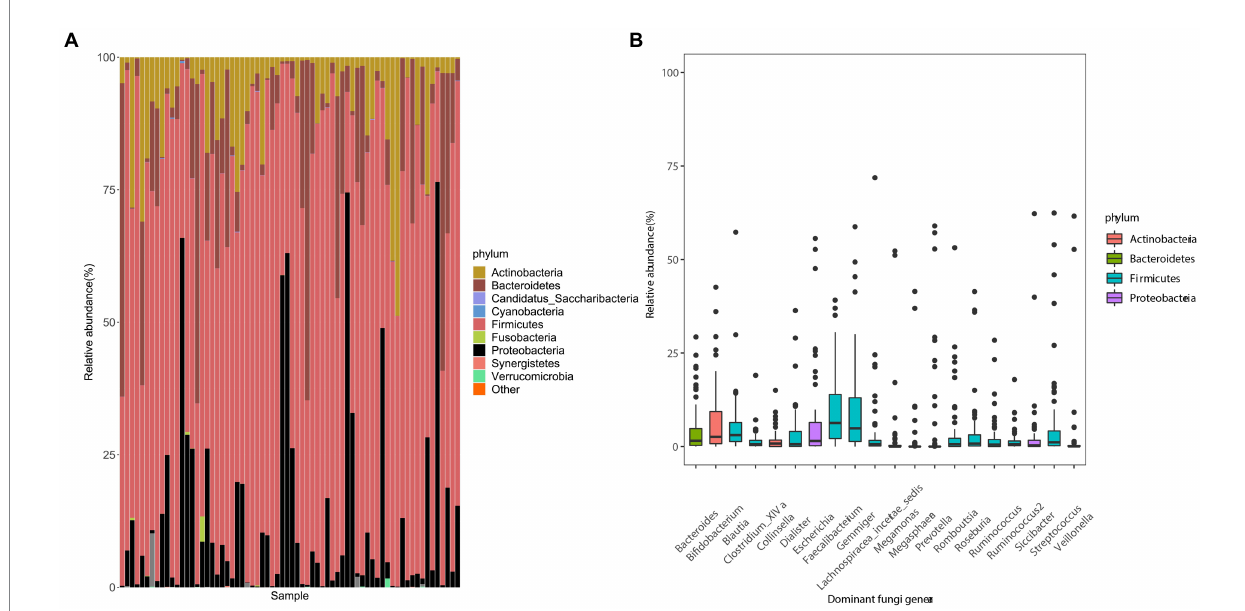
FIGURE 1 Composition of gut microbes and the average abundances of dominant bacterial genera in young adults. (A) Composition of the gut microbiota at the phylum level. (B) Composition of dominant bacterial genera (mean relative abundance >0.1%). The color corresponds to the name of each species at the particular taxonomic level and the width of the color block indicates the relative